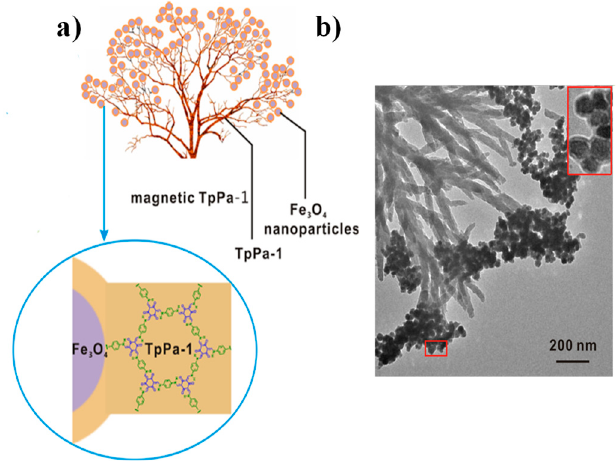
Figure 1. ( a ) The structure of the bouquet-like magnetic TpPa-1 sorbent, and ( b ) TEM image